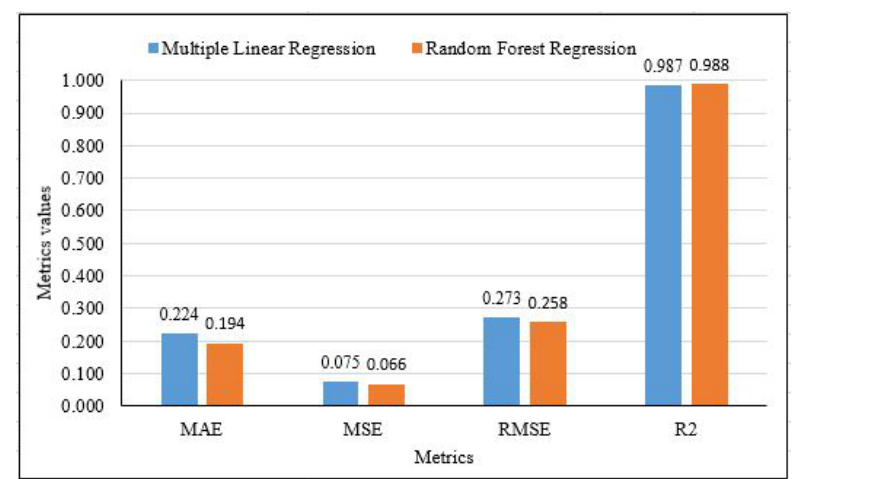
Figure 12. Fitting accuracy: actual and predicted results.